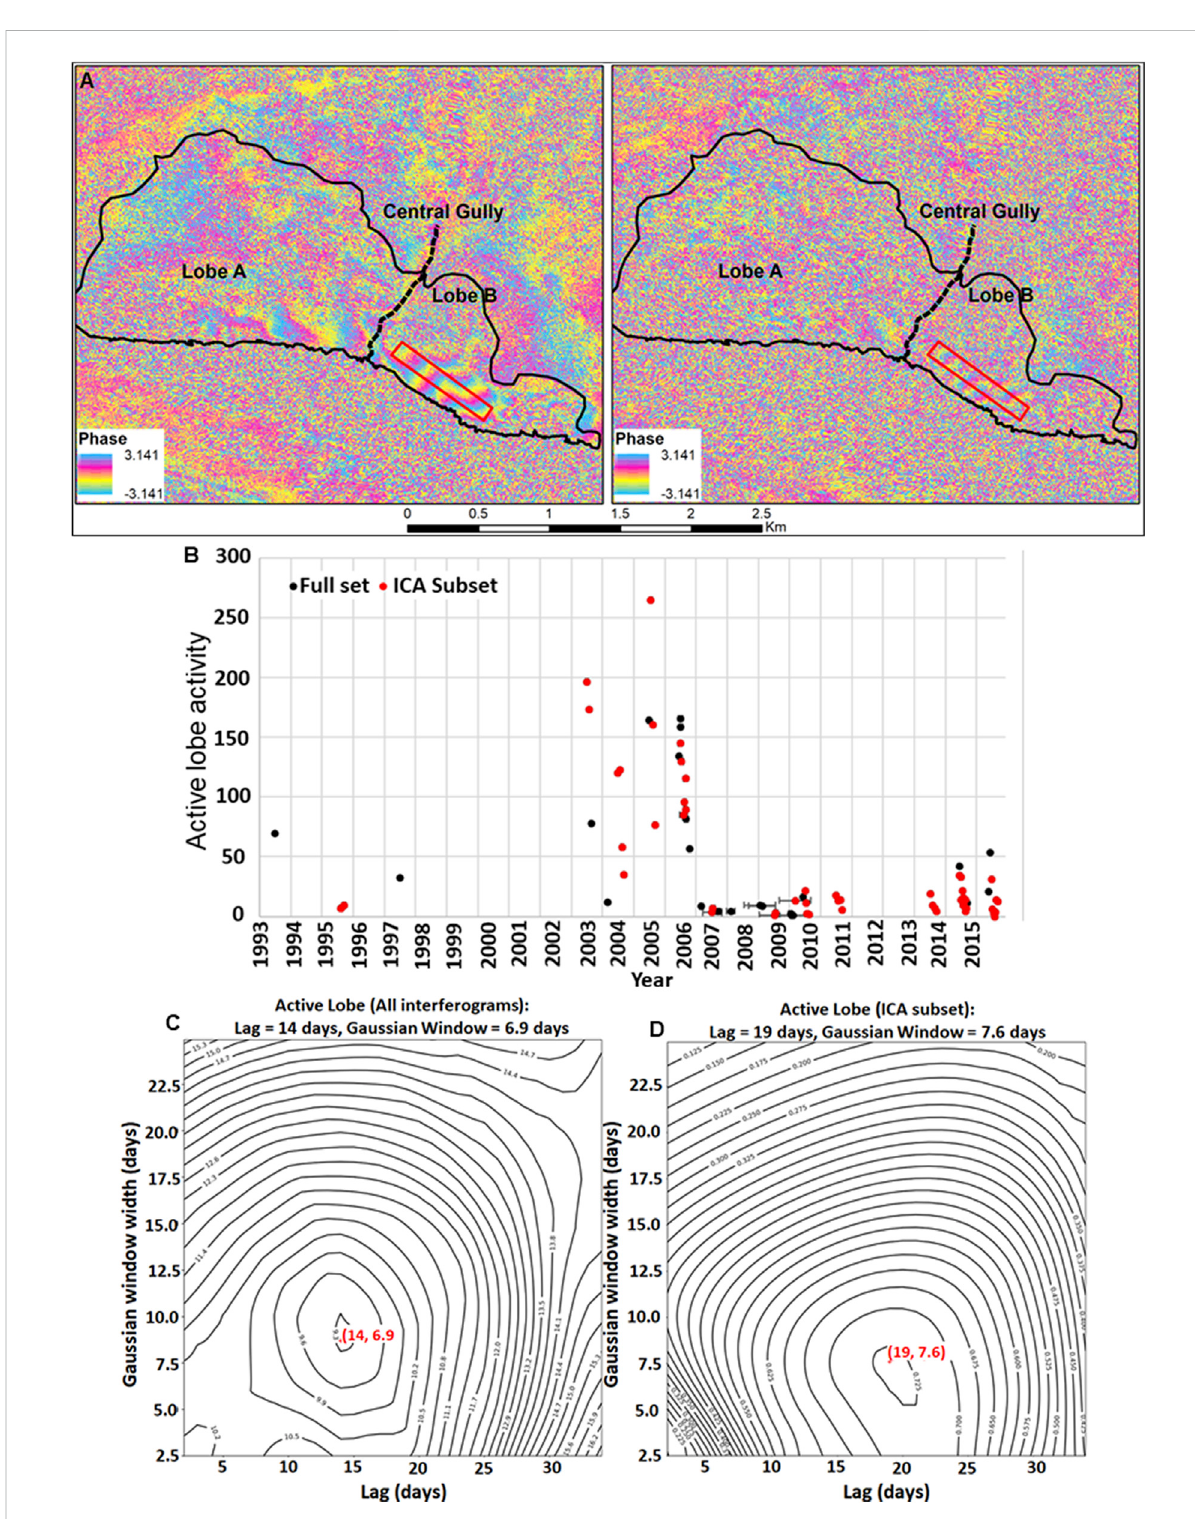
FIGURE 13 Results of our investigation of robustness of Gaussian parameter inversion for propagation of the hydrological driver to depth. (A) Example of interferogramswith low temporalcorrelation, showingthe area(outlined inred) that maintainscoherence. (B) Displacementgradient time series for thefullInSARdataset(blackdots)andthesubsetusedforICA(reddots). (C) 2Dcorrelationcontourplotofaveragesub-annualcorrelationcoef fi cient between gradient magnitude ofthefullInSARdataset andthepropagated driver;best- fi tparameter results (lag, standarddeviation)indicatedin red. (D) Equivalent to plot C but with displacement gradient magnitudes derived only from the ICA InSAR